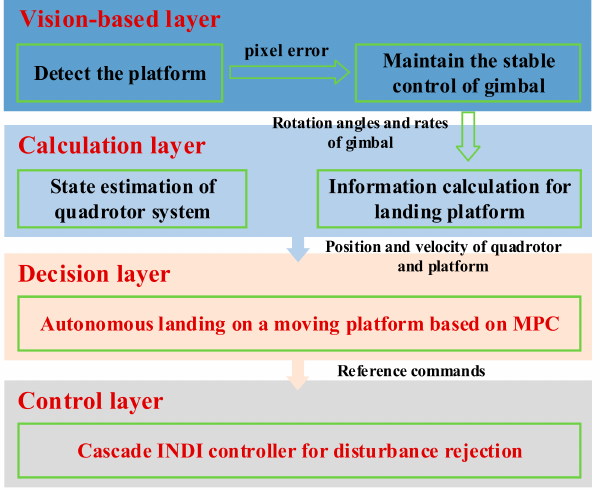
Figure 2. Four functional layers and the information transmission of the designed landing